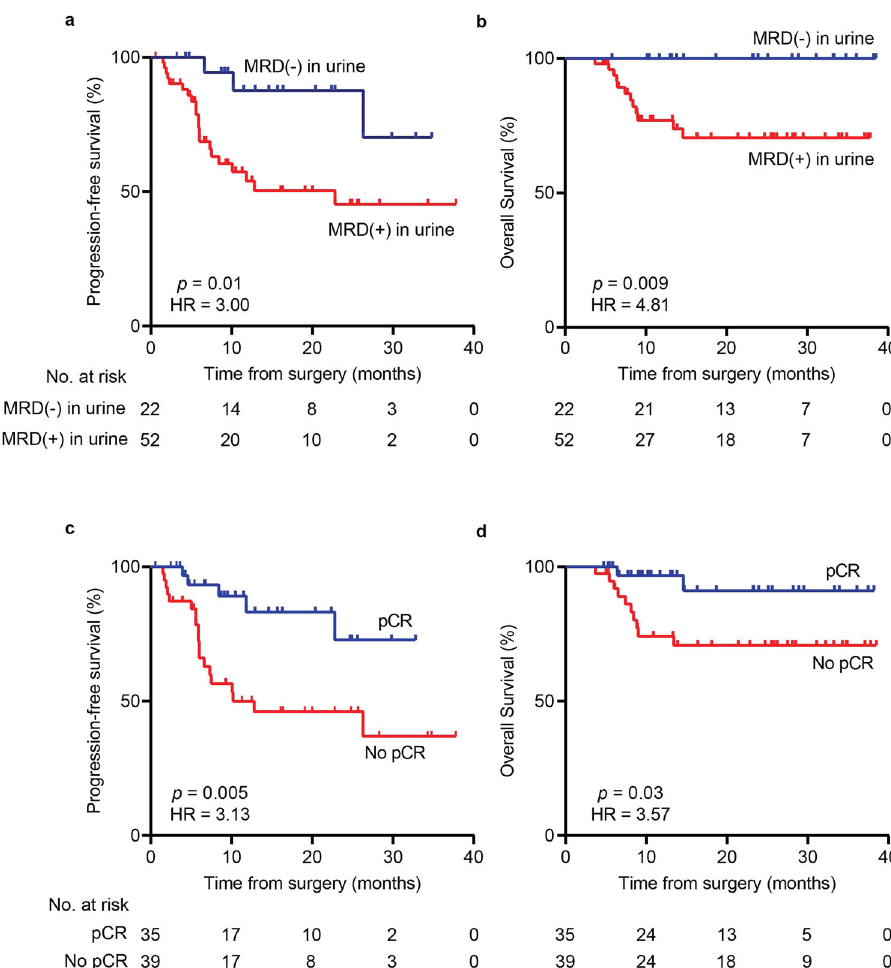
Fig. 2 Survival analysis comparing urine MRD detection to pathologic analysis of the resection specimen. Kaplan – Meier plots showing a progression-free survival and b overall survival strati fi ed by MRD detection in urine, determined by the LOOCV random forest model (Supplementary Fig. 5). c Progression-free survival and d overall survival strati fi ed by pCR determined by microscopic analysis of the radical cystectomy specimen. Survival times shown are relative to the time of radical cystectomy. p values were calculated by the log-rank test and HRs by the Mantel – Haenszel method. HR hazard ratio, LOOCV leave-one-out cross-validation, MRD molecular residual disease, pCR pathologic complete